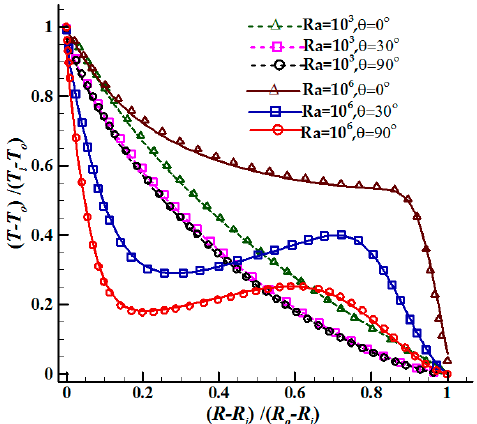
Figure 7. Temperature distribution along the gap between the inner and outer hexagonal cylinders at di ff erent angular directions, θ = 0 ◦ , θ = 30 ◦ , and at θ = 90 ◦ for AR = 0.2. The symbols represent corresponding data from Fluent software.